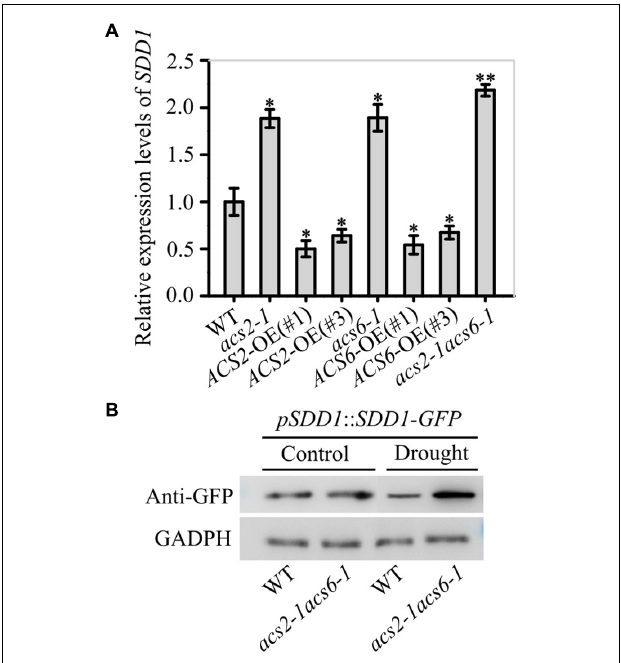
FIGURE 7 | ACS2/6-generated ACC buffering of Ca 2 + activity in stomatal lineage cells. (A) The relative fluorescence intensity of YC3.6 expression in stomatal lineage cells of immature leaves of NES-YC3.6-expressing WT or acs2-1acs6-1 plants or by drought treatment. Representative images from at least 25 leaves in each line are shown. Pseudocolors in images correspond to relative Ca 2 + levels according to the color scale on the right. Scale bar, 10 µ m. (B) Evaluation of Ca 2 + levels in stomatal lineage cells (labeled with yellow circle) of immature by calculating the ratio of the FRET acceptor cpVenus (at 525–555 nm) to the FRET donor CFP (at 465–499 nm). The experiment was repeated three times with consistent results. Values are means ± SD (Student’s t -test; ∗∗ P <